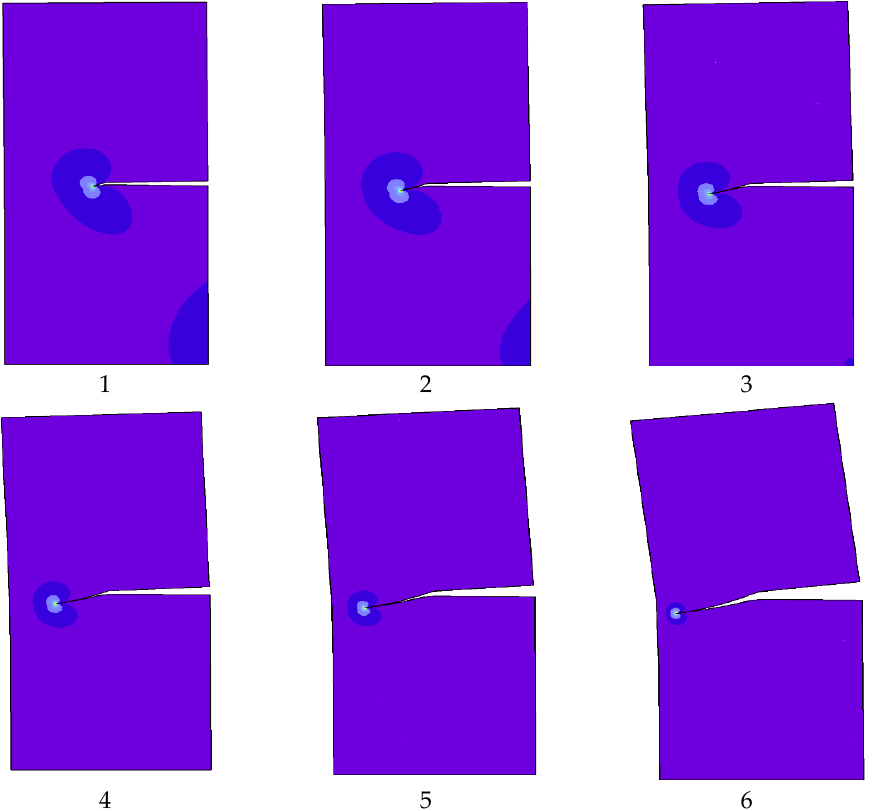
Figure 12. Steps of crack propagation simulation for the single edge notched specimen under shear load.